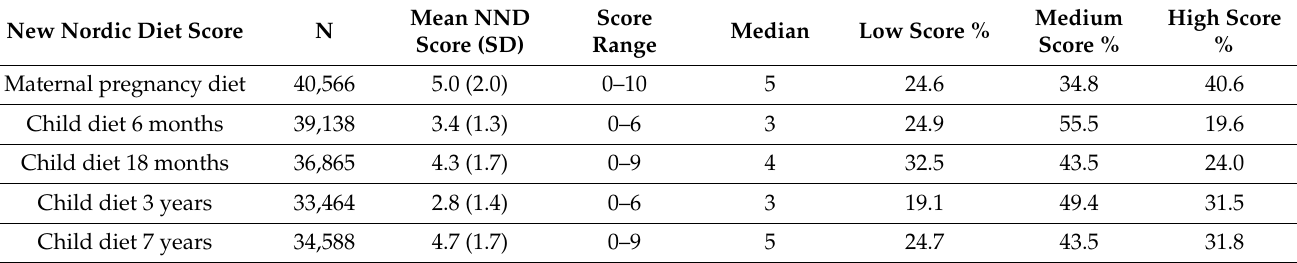
Table 1. Detailed description of the different New Nordic Diet (NND) scores (exposure) at time of assessment. Valid proportion of participants in each NND